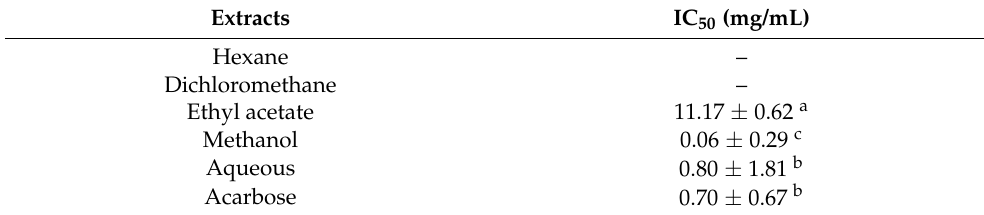
Table 3. IC 50 values of various extracts of E. humile against α